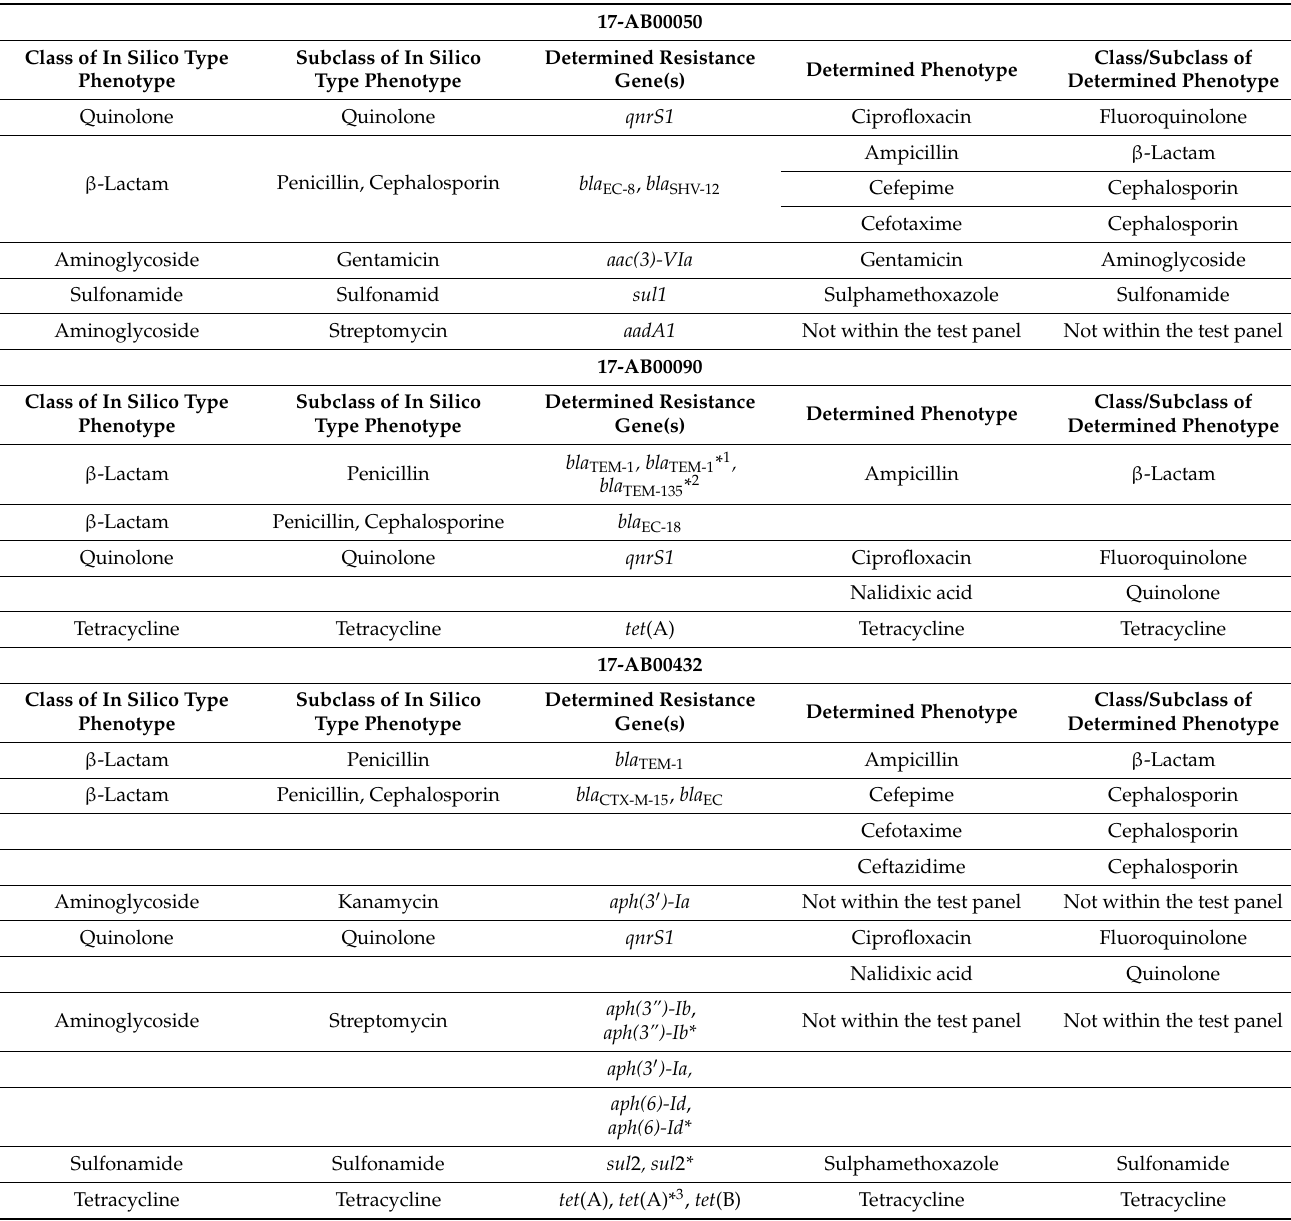
Table 4. Antimicrobial resistance phenotype and resistance determinants predicted with various assembly and sequencing techniques in five E. coli